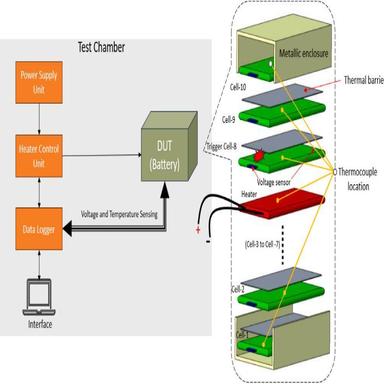
Module or pack level stacking of cells with thermal barriers.